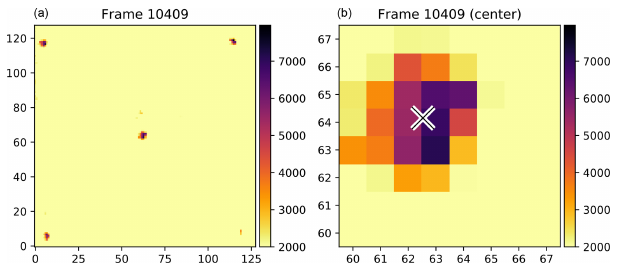
Figure 13. Measurements of the five light sources delivered by the pointing calibration optics. Panel (a) shows the full detector, which was read out with 128 × 128 pixels for this measurement. Panel (b) shows a close-up of the central beam that highlights the 0 ◦ pitch/90 ◦ azimuth